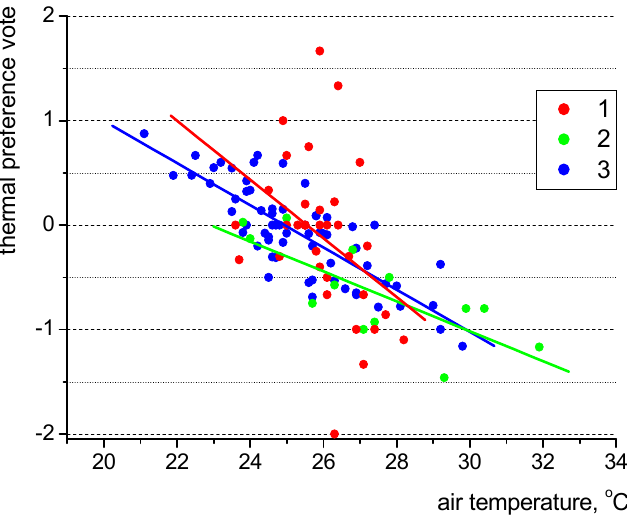
Figure 10. Thermal preference votes vs. indoor air temperature in the Courthouse (1), “A” building (2) and “Energies” (3) with the best fit linear approximations. (the red line is for the Courthouse, the green line for “A” building and the blue line for “Energis”),.